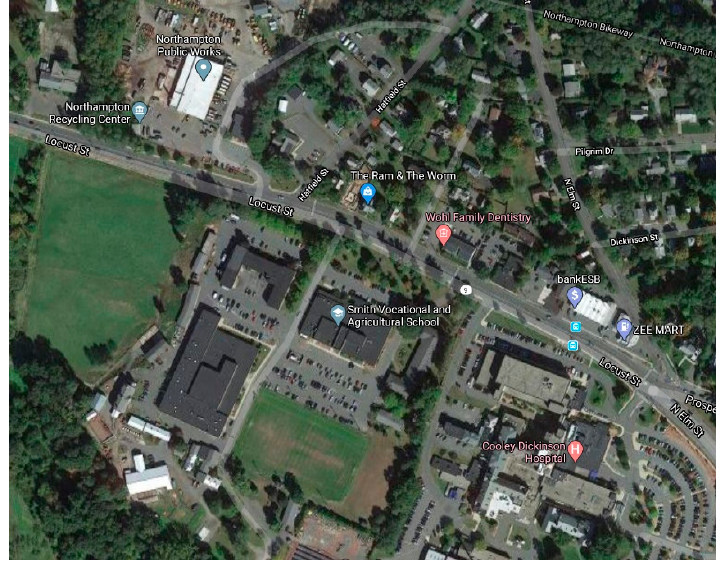
Figure 1. Satellite Google Earth image of CDH, SVAHS, and Northampton DPW. Map data: Apache License, Version 2.0, Google, 2020 [14,15].